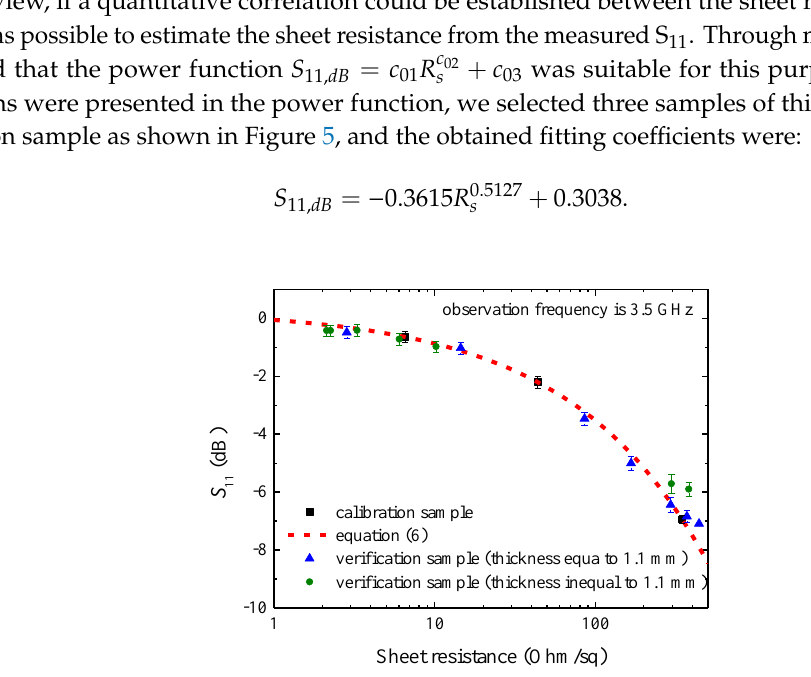
Figure 5. Measured dependence of S 11 on sheet resistance at 3.5 GHz for all of the samples. The fitting curve calculated using Equation (6) is also shown for comparison.